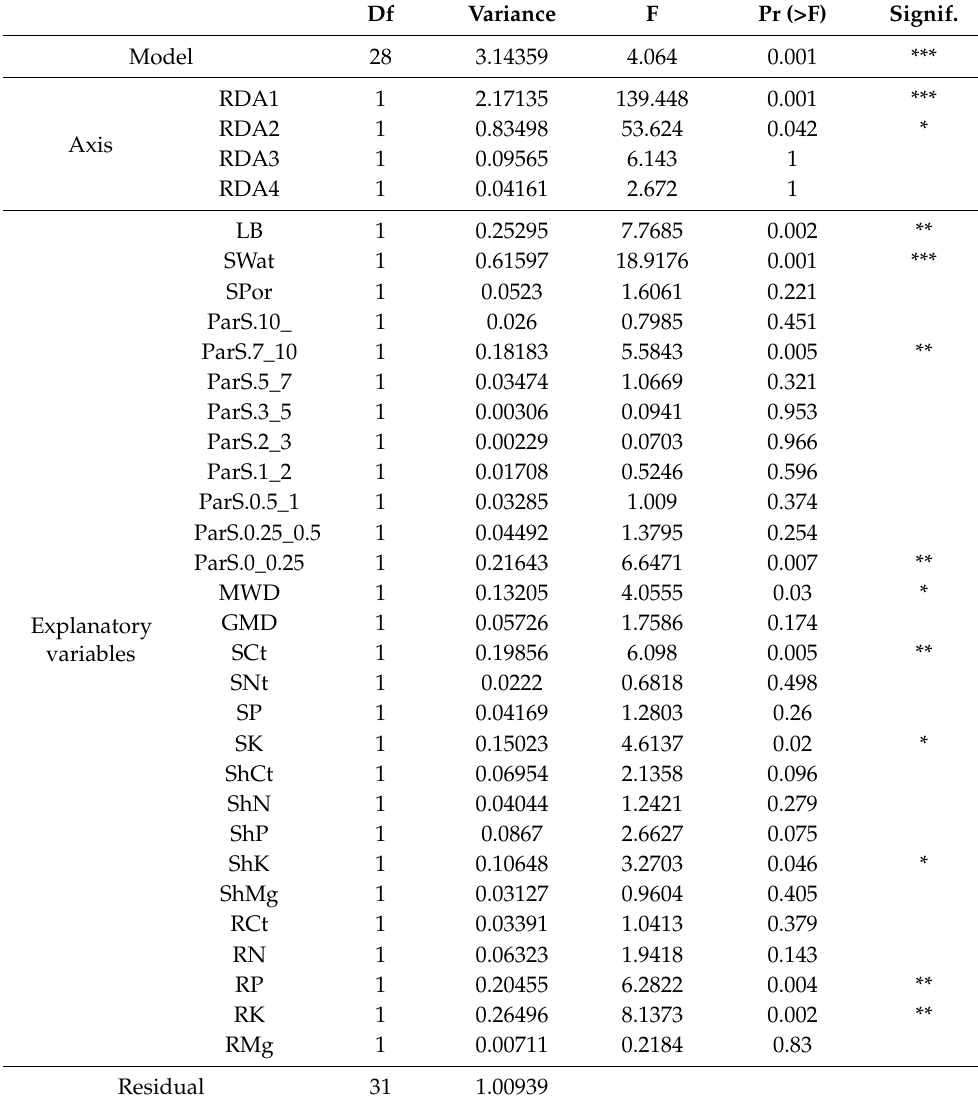
Table 4. Permutation test for RDA under reduced